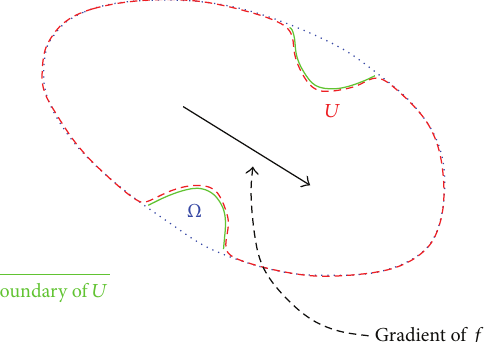
Figure 2: Example of a function which is Lebesgue monotone, but not Mostow